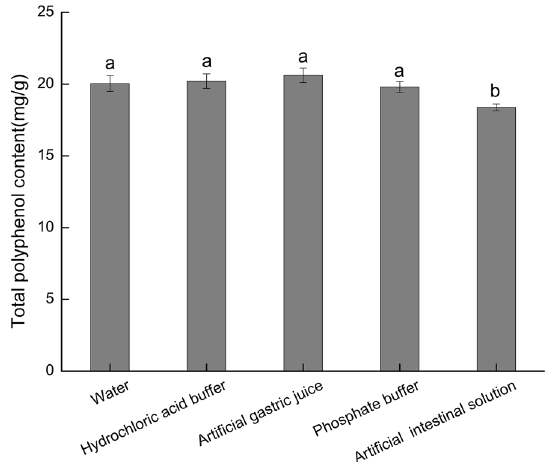
Fig. 2 Total polyphenols content of secondary residues of Turkish Gall by different treatment conditions. Different letters ( a , b ) indicate significant difference ( p <